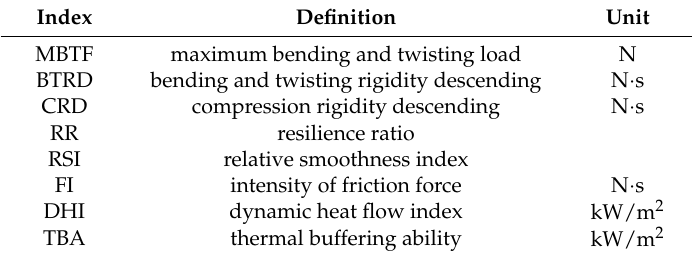
Table 1. Indices defined for mechanical and dynamic heat transfer properties.